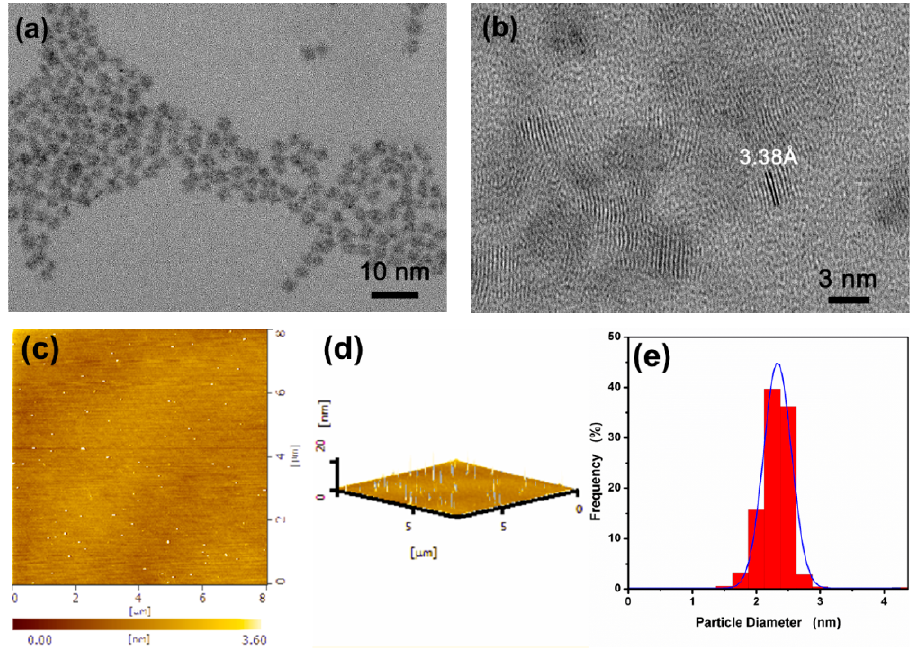
Figure 4. TEM and HRTEM images ( a , b ) of the as-synthesized CA-CdS QDs; ( c ) and ( d ) represents 2D and 3D AFM images of CA-CdS QDs deposited on silicon substrate, respectively; ( e ) Statistical analysis of the heights of CA-CdS QDs measured by AFM.